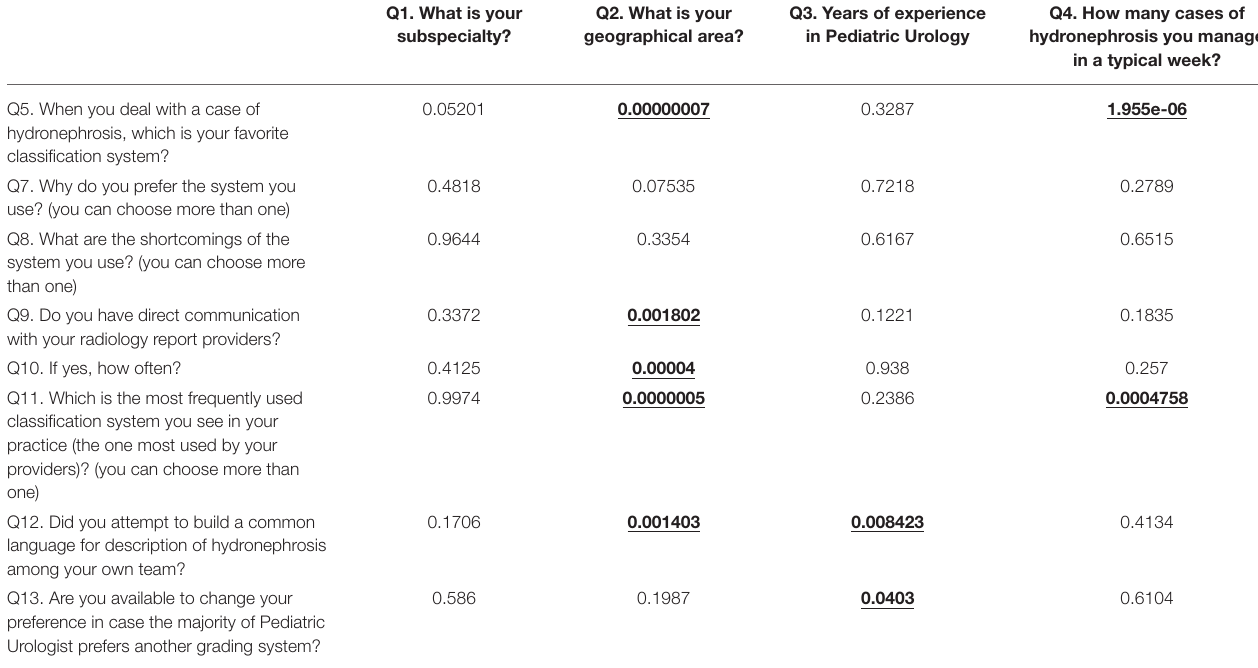
TABLE 1 | P -values corresponding to a G-test of independence between the variables Q5, Q7, Q8, …Q13 and the demographic variables Q1, …, Q4.